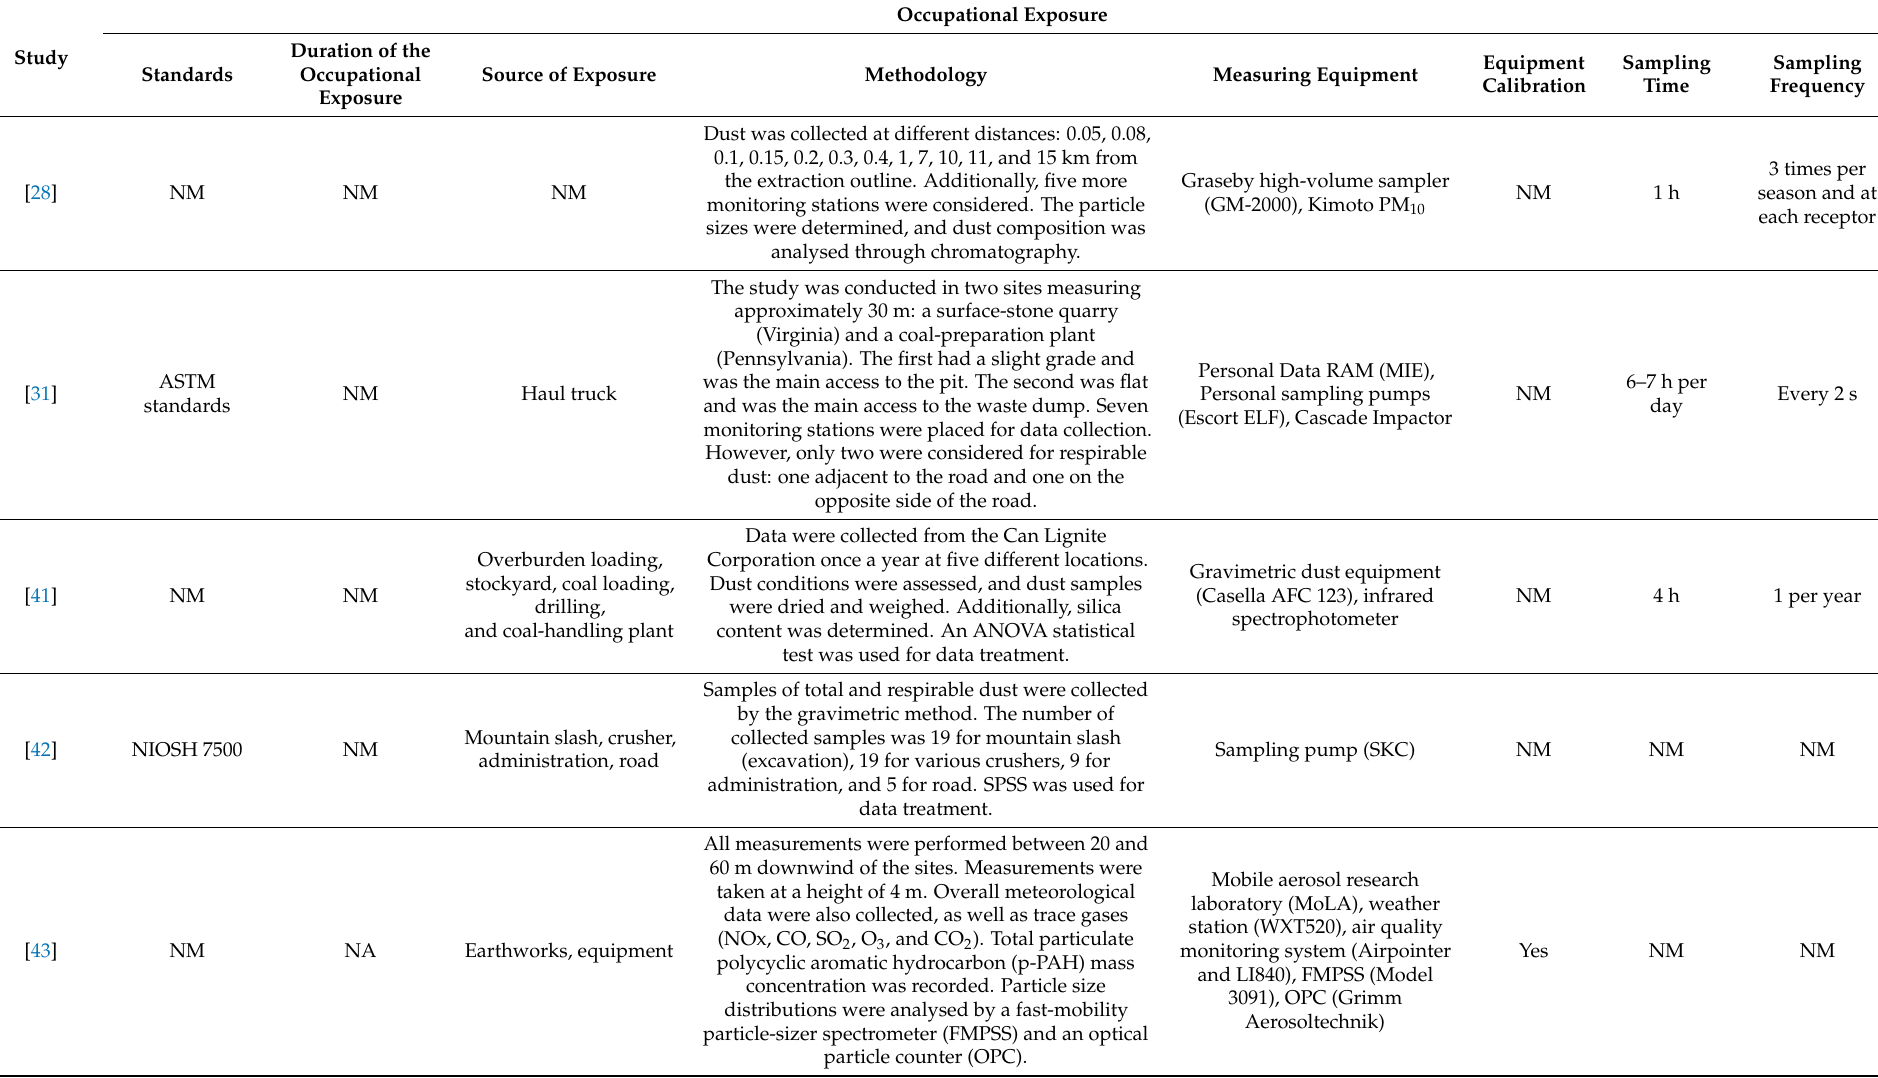
Table A2. Occupational exposure characterisation per